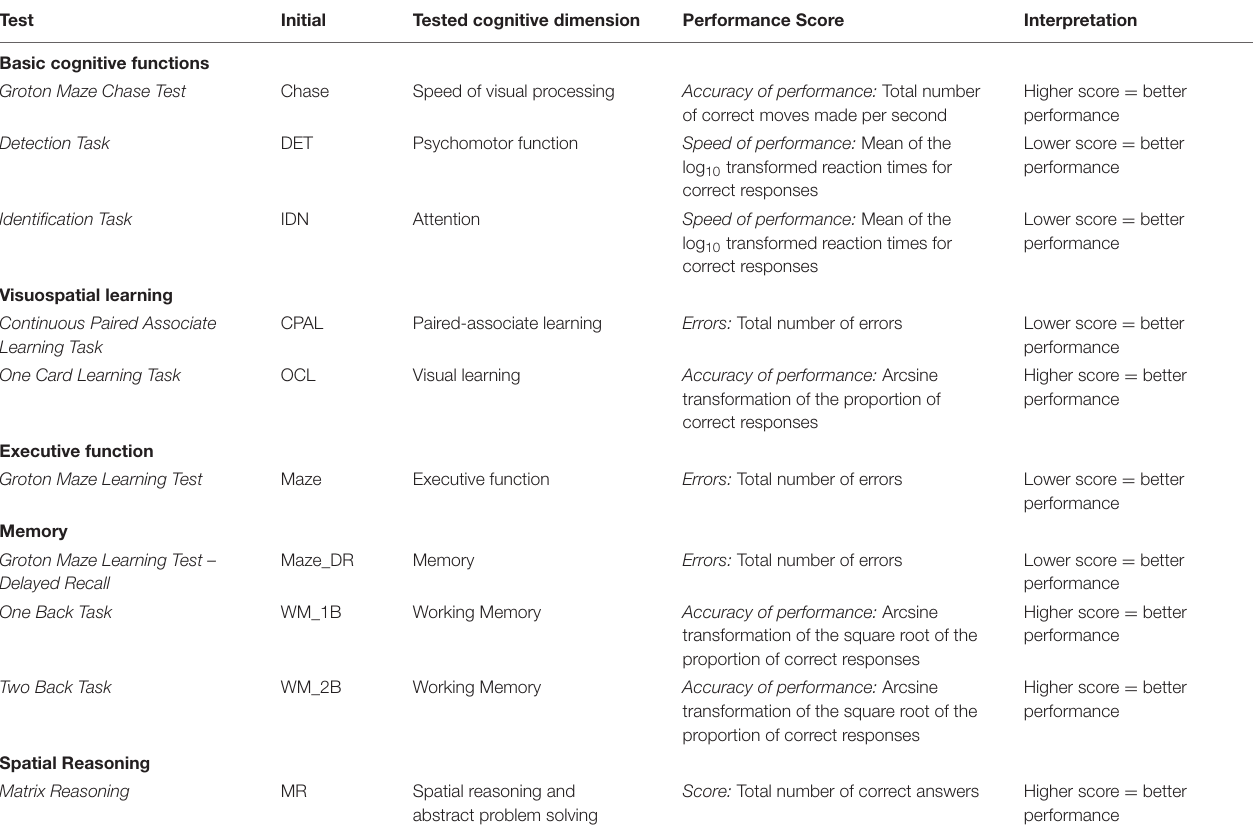
TABLE 1 | Description of the cognitive tests